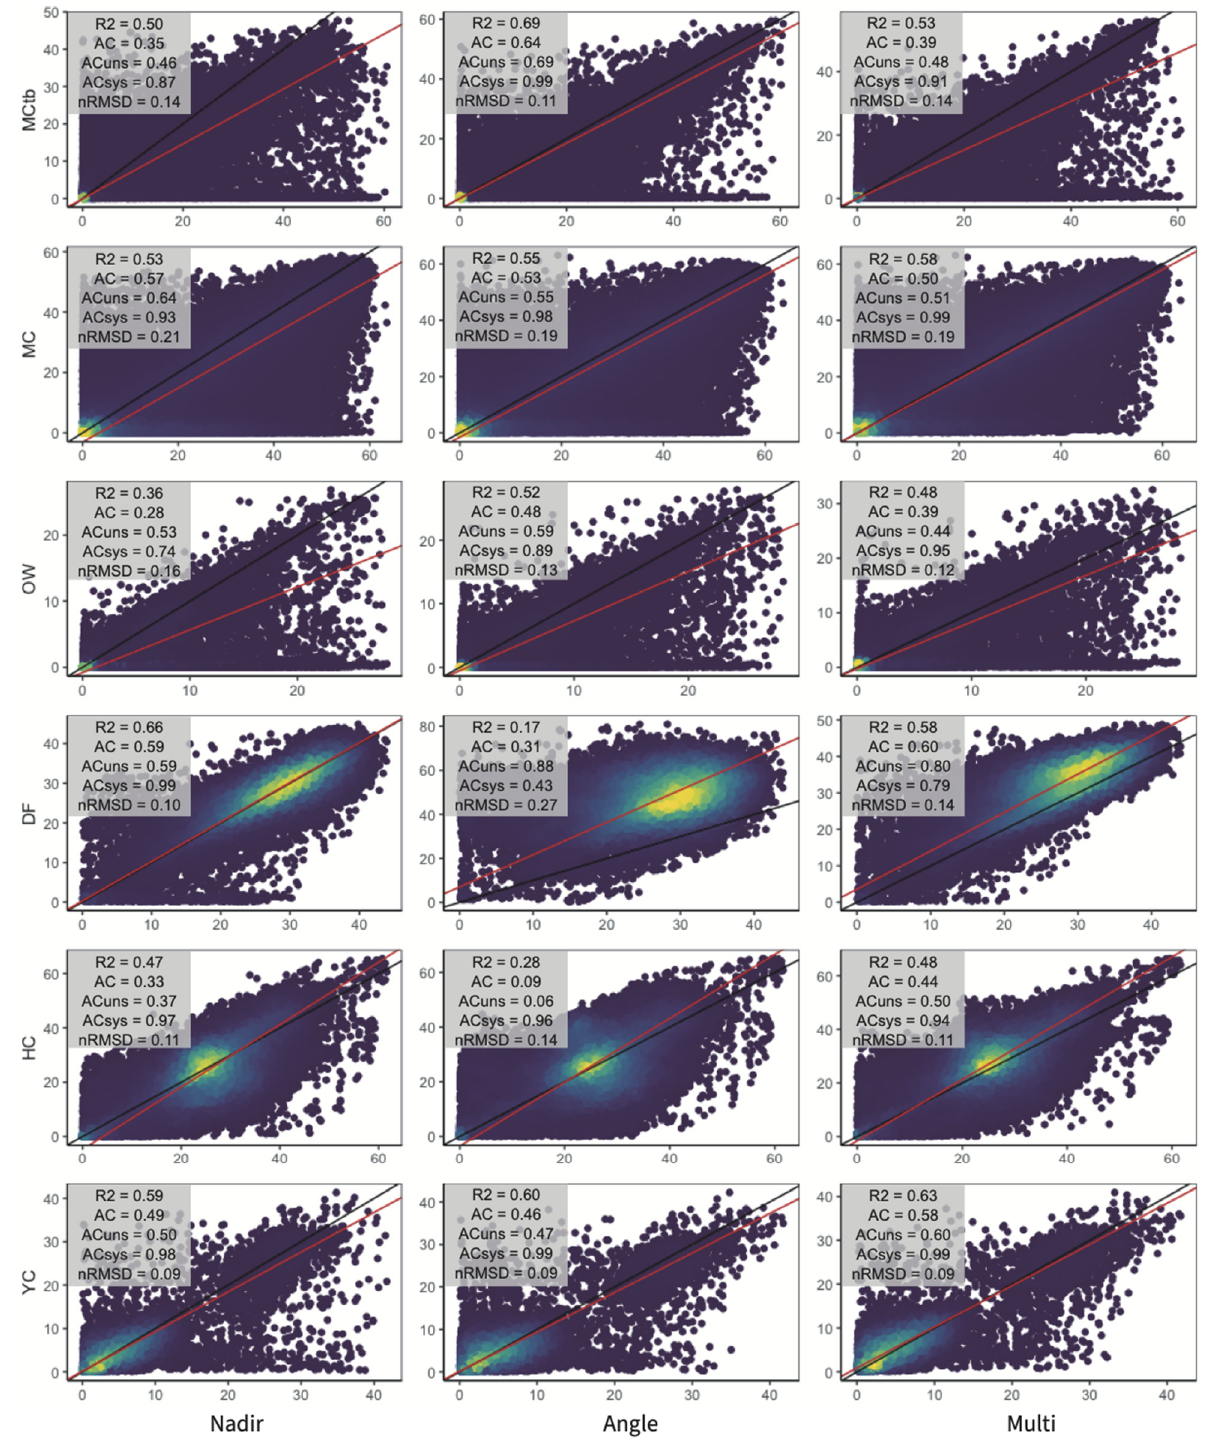
Figure 5. Comparison of site-specific canopy height models (CHM) generated from UAS DAP (nadir, angled, and multi- angled) versus lidar. The X axis is DAP and the Y axis is lidar. Geometric mean fit regression line in red, 1:1 line in black, points are colorized by density of observations (i.e., number of raster pixels) with lighter regions (yellow) indicating greater density of observations and darker regions (blue) being less dense. R-squared, root mean square deviation (RMSD), normalized RMSD (nRMSD), agreement coefficient (AC), systematic agreement coefficient (AC sys ) and unsystematic agreement coefficient (AC uns ) are shown for each model comparison.